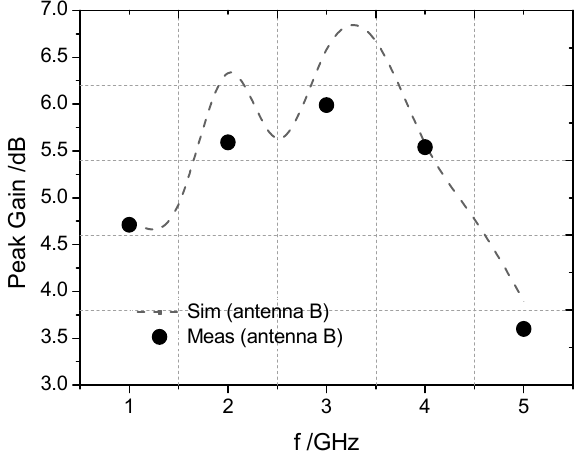
Figure 12. Simulated and measured peak gain of the proposed antenna B.